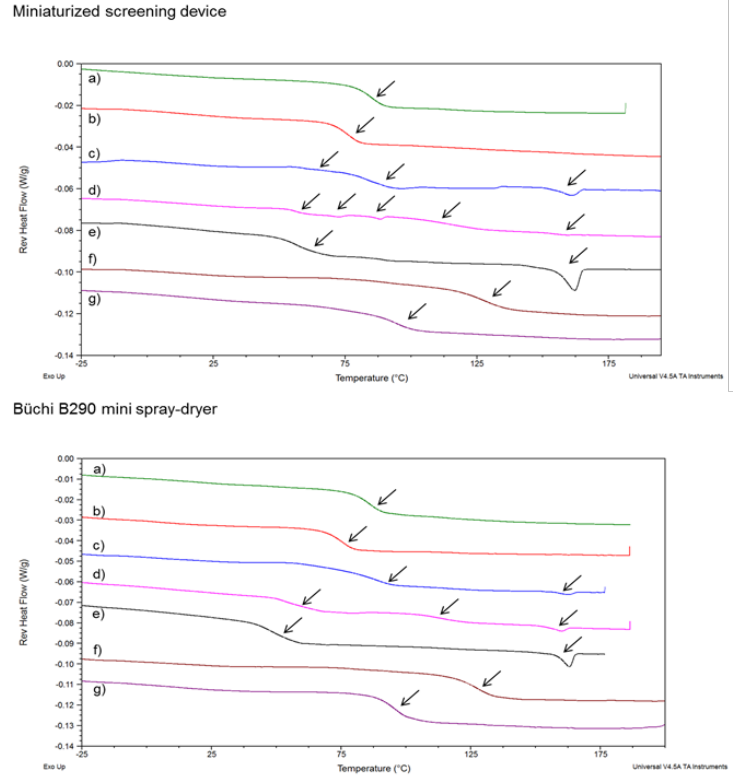
Figure 6. Reverse heat flow signals of 60:40 ( w / w ) SDSDs of itraconazole with HPMCP HP50 ( a ), HPMCAS-LF ( b ), PVPVA ( c ), PVPK30 ( d ), Soluplus ( e ), Eudragit L100 ( f ), and Eudragit L100-55 ( g ) produced by the miniaturized screening device and Büchi B290 mini